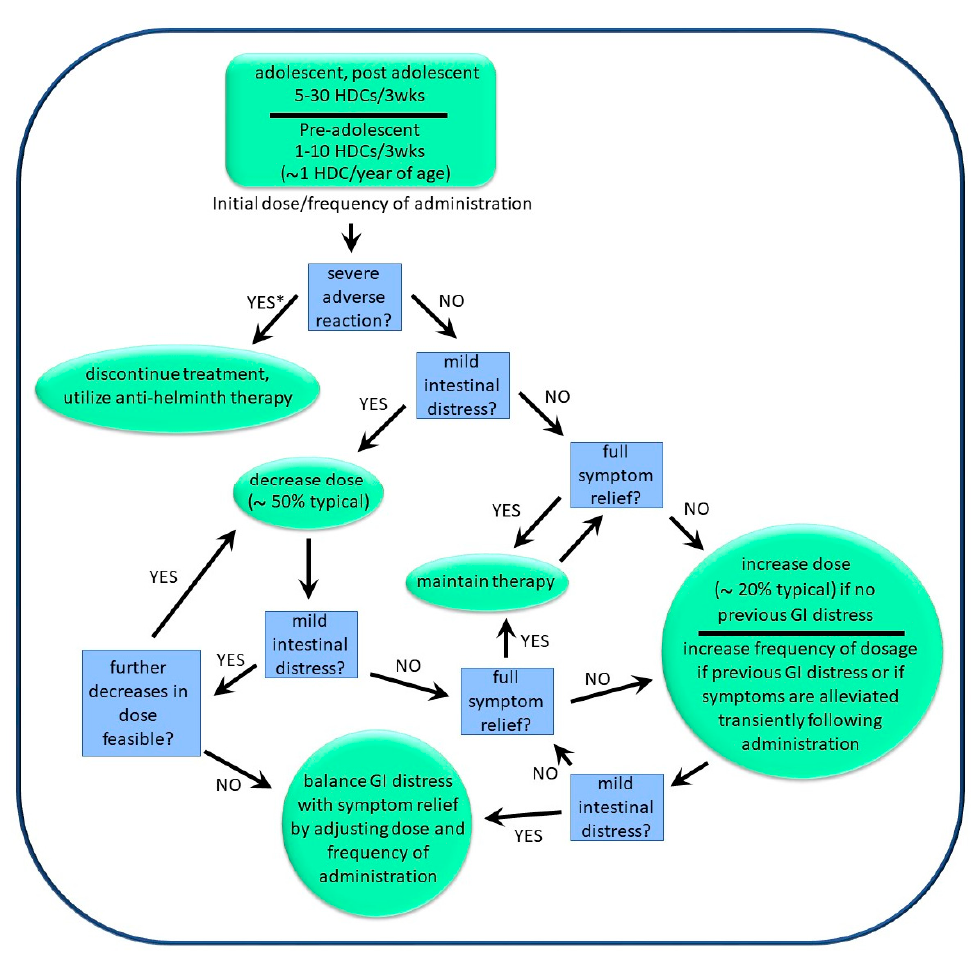
Figure 7. Decision tree for determination of optimal personal dosage and frequency of dosage of HDCs. * Substantial adverse reactions are rare and have thus far been limited to the pediatric population.